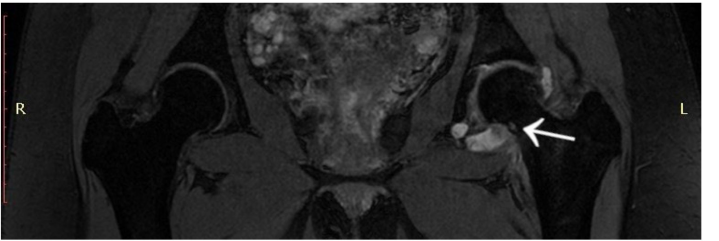
Figure 12. First MRI scan of the hip joints with visible focus of OO (arrow) in the femoral head/neck border, unnoticed.